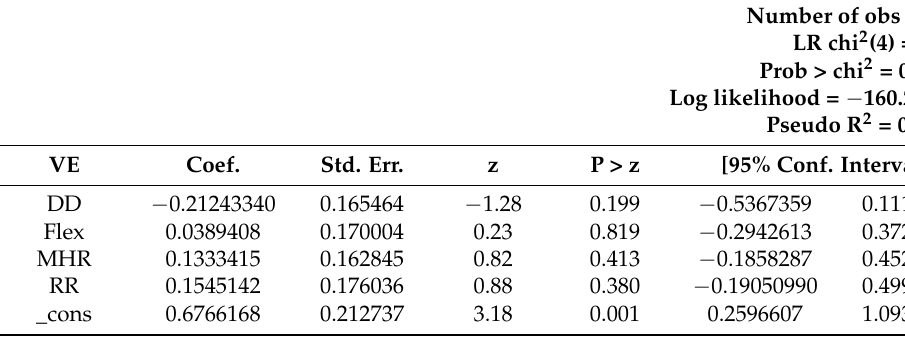
Table 6. Probit regression analysis with VE as dependent